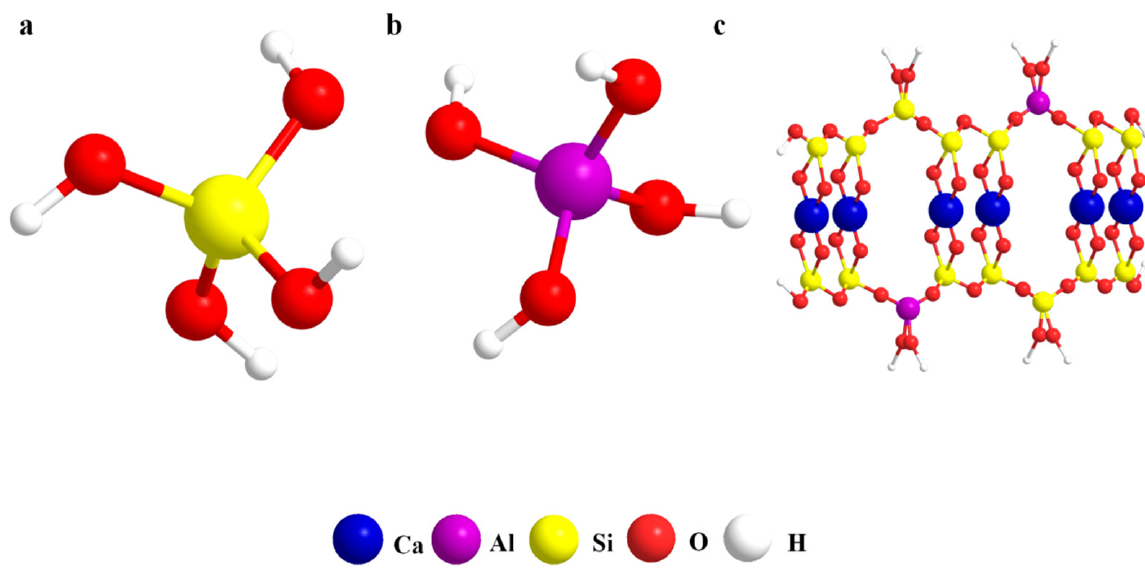
Figure 8. Structural model. (( a ): [H 3 SiO 4 ] − , ( b ): [H 3 AlO 4 ] 2 − , and ( c ): C-A-S-H gel).